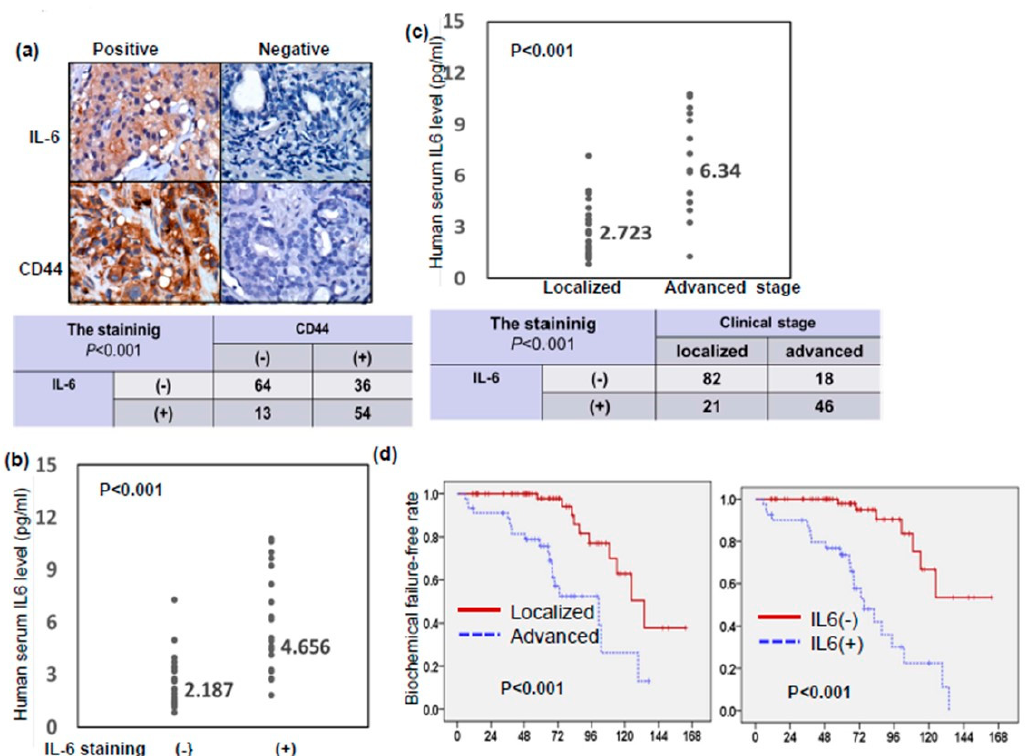
Figure 6. Role of IL-6 in patients with prostate cancer. ( a ) CD44 level was positively correlated with IL-6 expression in human prostate cancer specimens ( p < 0.001). Representative slides of tumor specimens positively or negative staining for IL-6 and CD44 are shown. Scale bars: 60 µm. ( b ) IL-6 levels measured using ELISA in serum from cancer patients with IL-6 negative and positive staining. The value indicated the median. ( c ) IL-6 levels measured using ELISA in serum from cancer patients with clinical localized stage or advanced stage. ( d ) The differences of biochemical failure-free survival according to clinical stage and the staining of IL-6 in patients with prostate cancers.